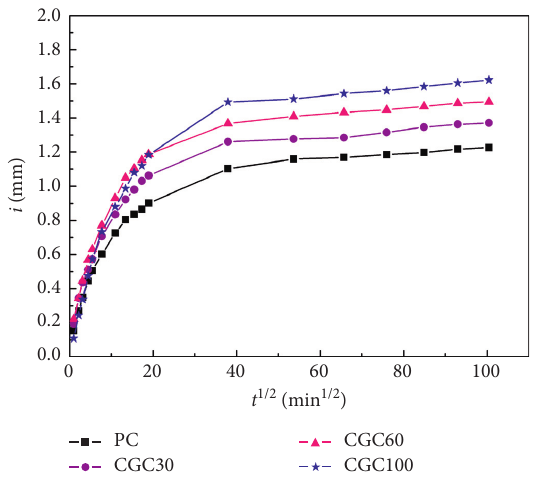
Figure 6: Relationship between water absorption height and square root of exposure